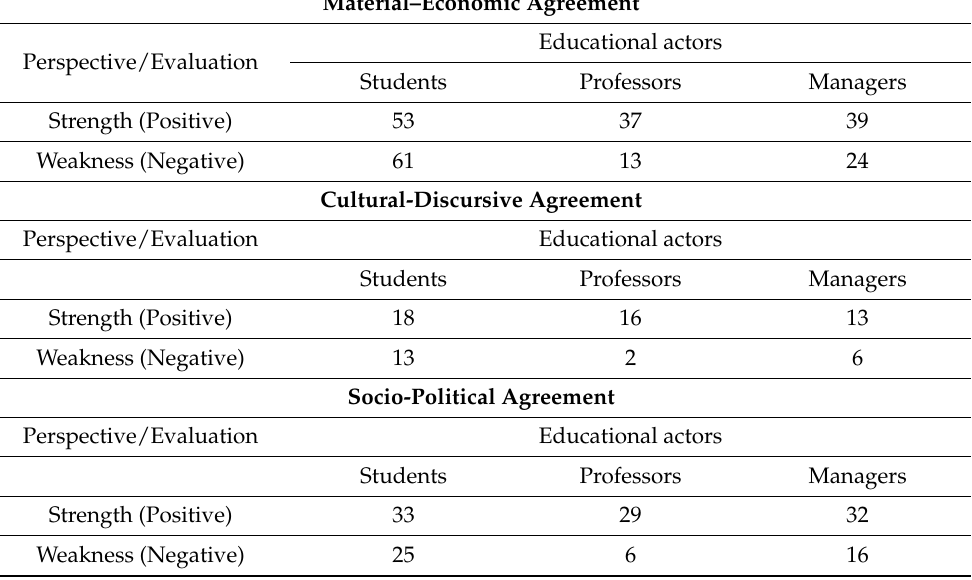
Table 6. Overall